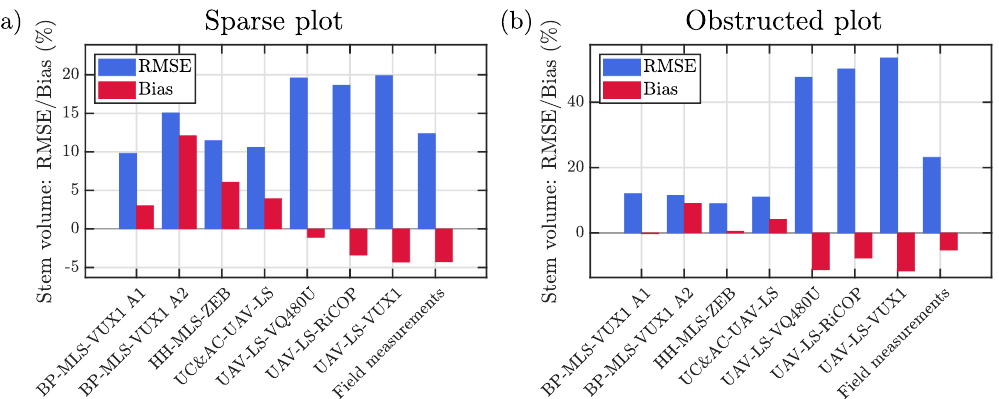
Figure 13. Relative bias and RMSE of stem volume estimation at the individual tree level for the different methods ( a ) in the sparse plot and ( b ) in the obstructed plot. BP, HH, and UC stand for backpack, handheld, and under-canopy, respectively. Note that the scales of the y axes are different in panels ( a , b